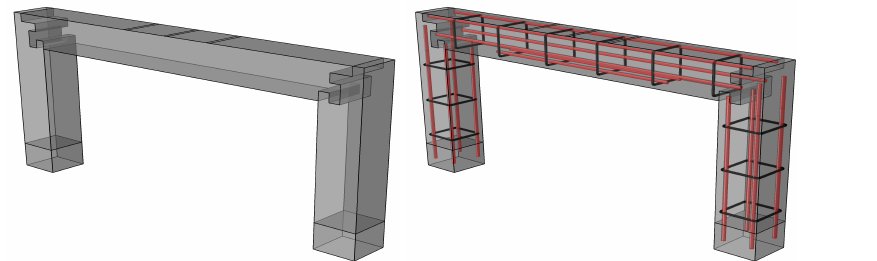
Figure 17. F7, Rebar layout and geometrical dimensions.